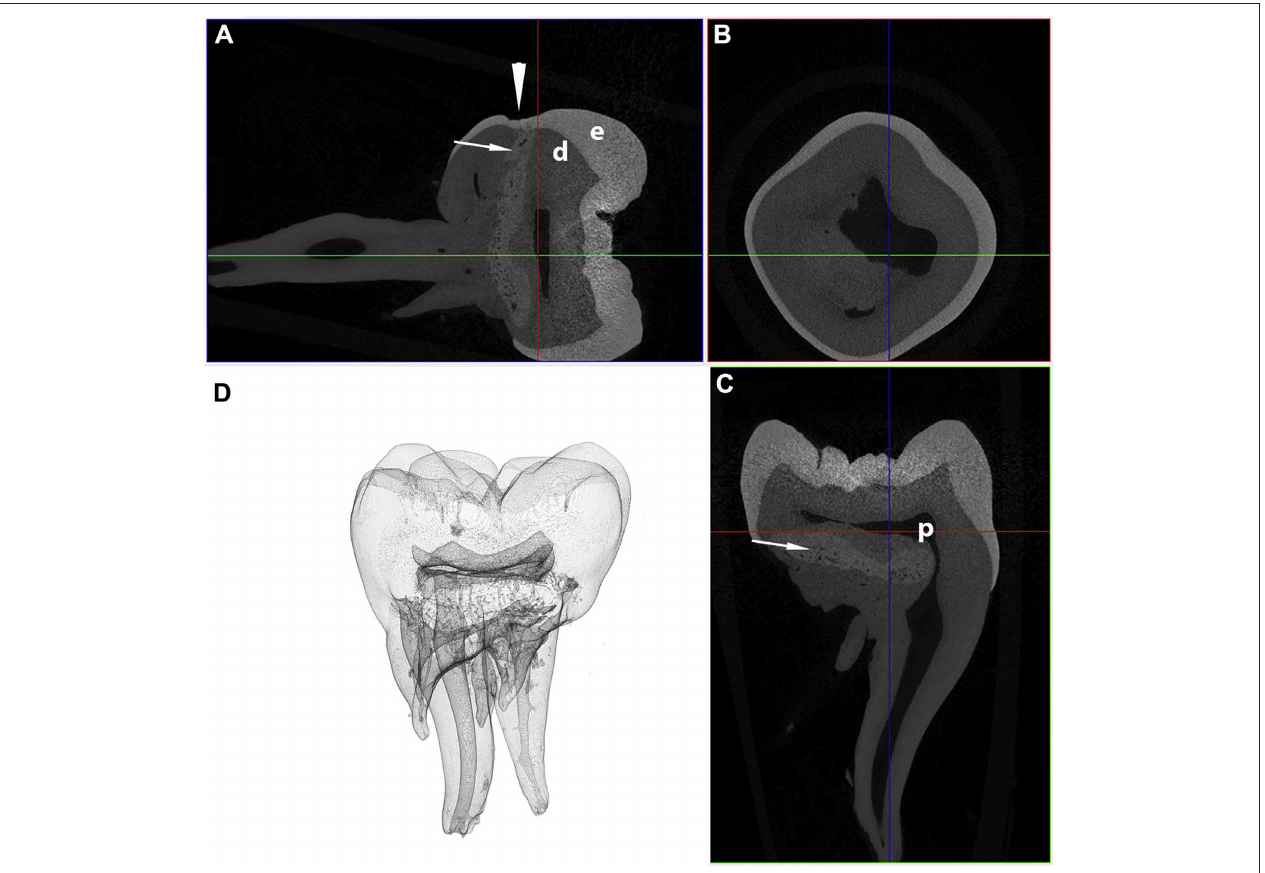
FIGURE 7 | Transverse (A) , coronal (B) , and sagittal (C) micro-CT images in bone algorithm and a 3D volume rendered reconstruction (D) of a human mandibular first molar with MIM. Note the abnormal tissue with attenuation characteristics between dentin and enamel at the cervical region (white arrows), as well as a depression in the enamel, known as a cervical constriction, at the level where the abnormal tissue contacts the dentinoenamel junction (white arrowhead) [from: Brusevold et al. (47)—reproduced with